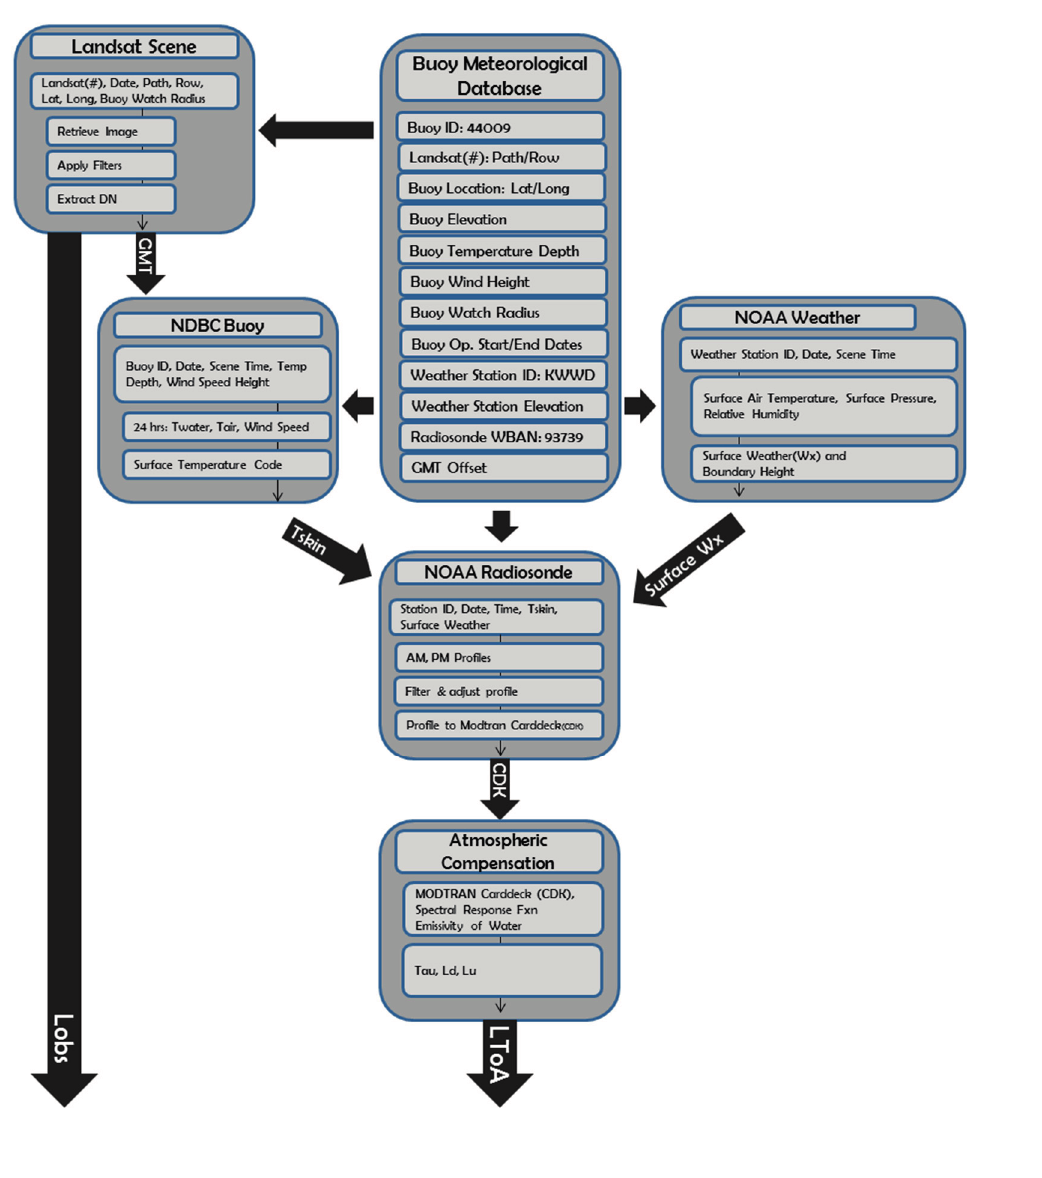
Figure 5. Workflow illustrating: assembling the necessary inputs, Landsat scene filtering, buoy to surface temperature adjustment, and atmospheric